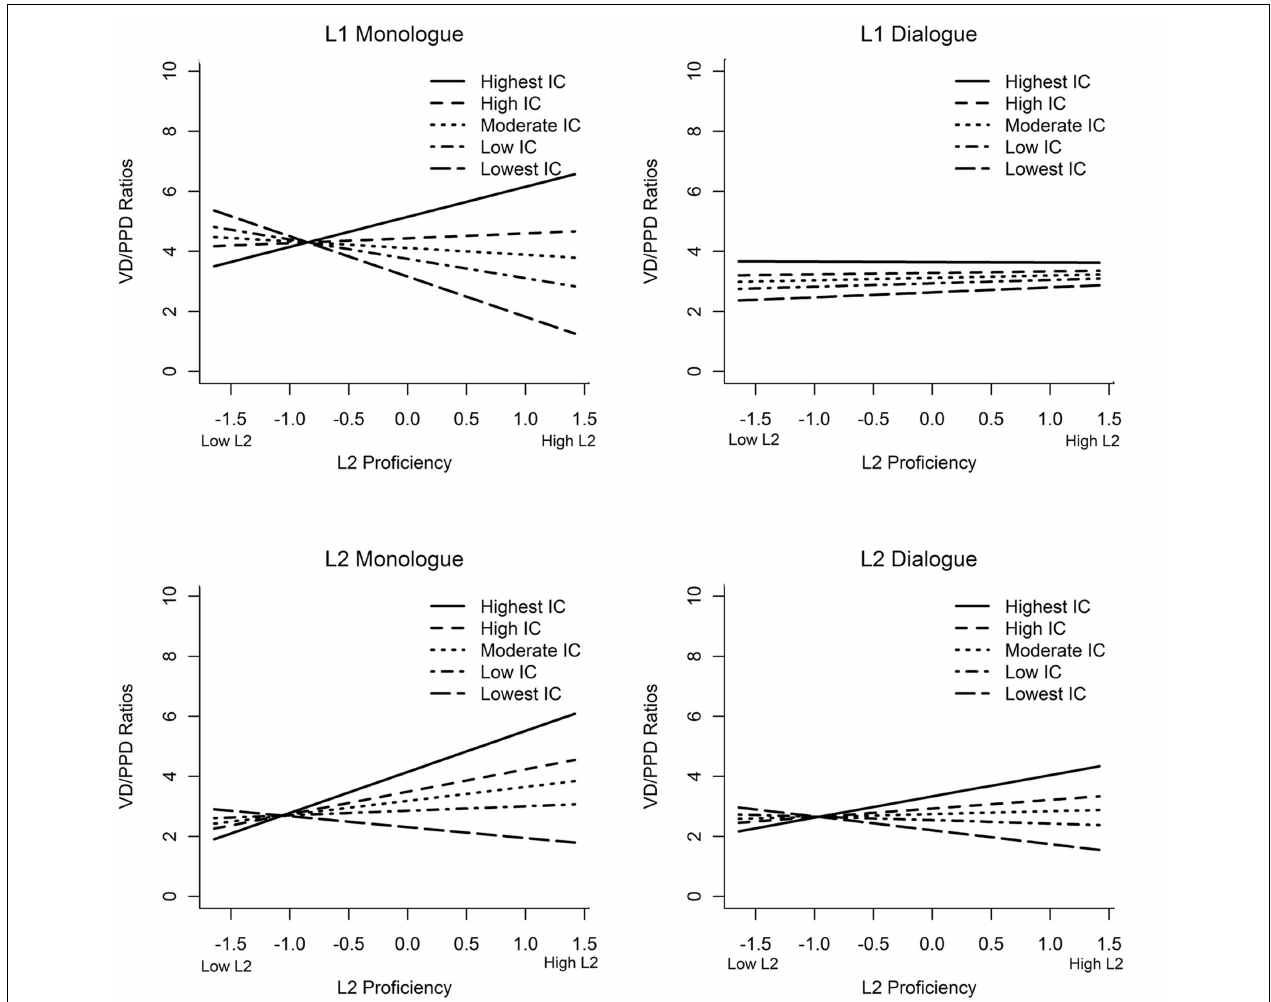
L2 proficiency levels in monologues. Speech planning and production is more efficient for bilinguals with high vs. low inhibitory capacity at high L2 proficiency levels in L2 dialogues. Speech planning and production is not different across all inhibitory capacity levels at low L2 proficiency levels in monologues and